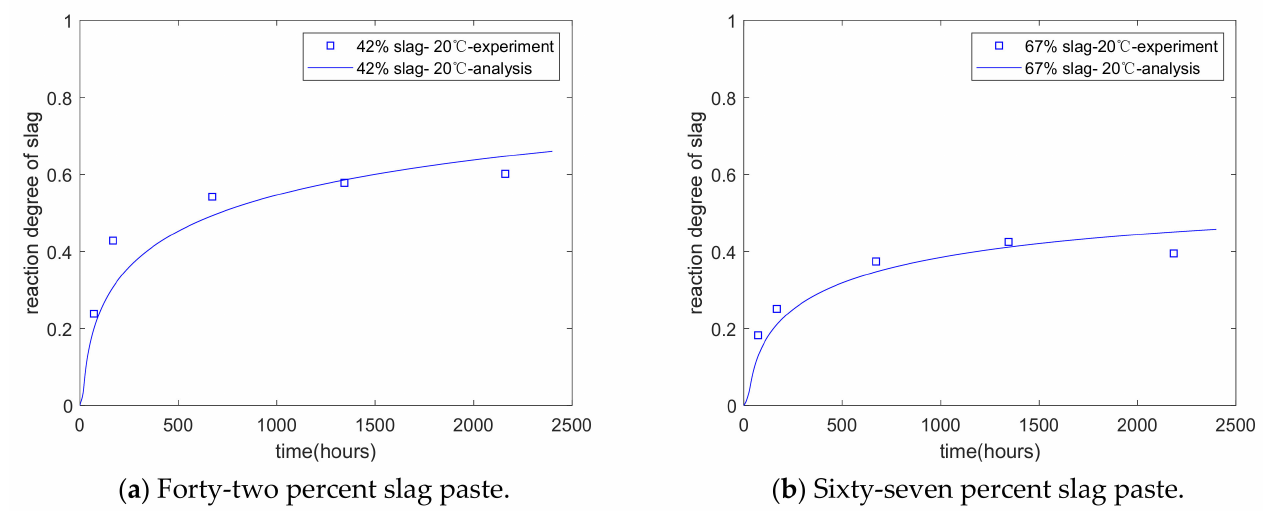
Figure 6. Long-term reaction degree of